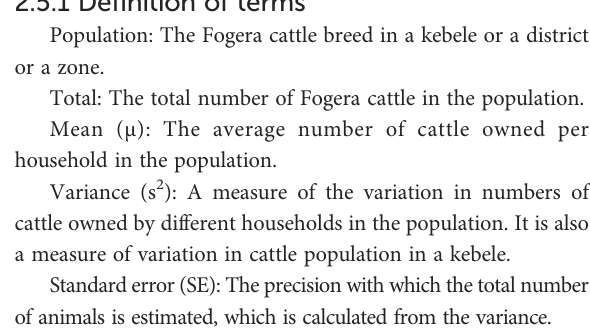
Population: The Fogera cattle breed in a kebele or a district or a zone. Total: The total number of Fogera cattle in the population. Mean (μ): The average number of cattle owned per household in the population.